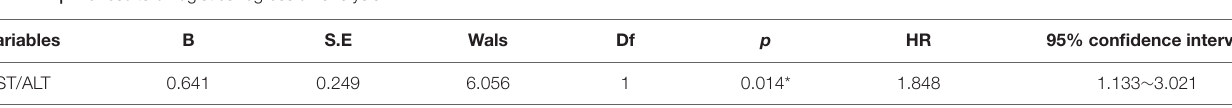
TABLE 4 | The results of logistics regression